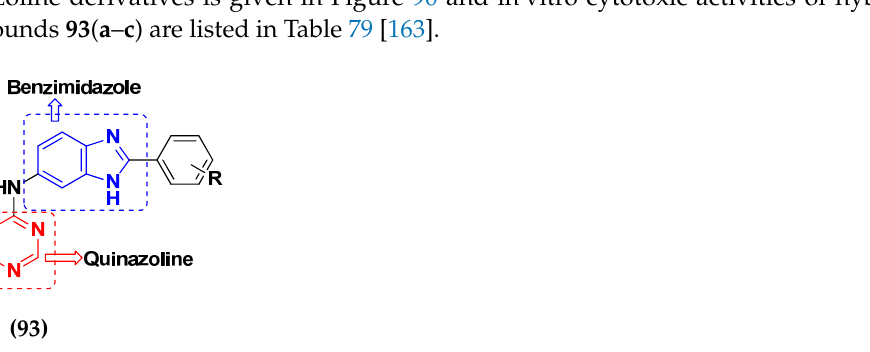
Figure 90. Structure of benzimidazole-quinazoline derivatives ( 93 ). Table 79. In vitro cytotoxic activities of benzimidazole-quinazoline hybrid compounds 93 ( a – c ).